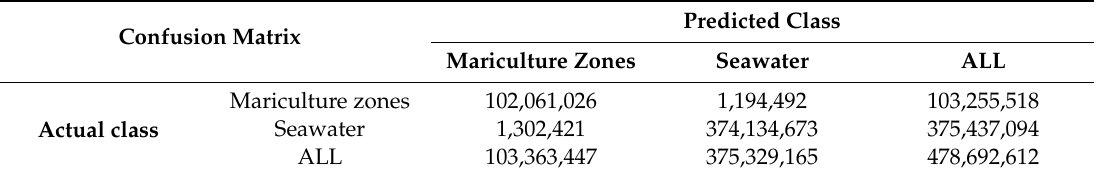
Table 4. Confusion matrix of the classification results.